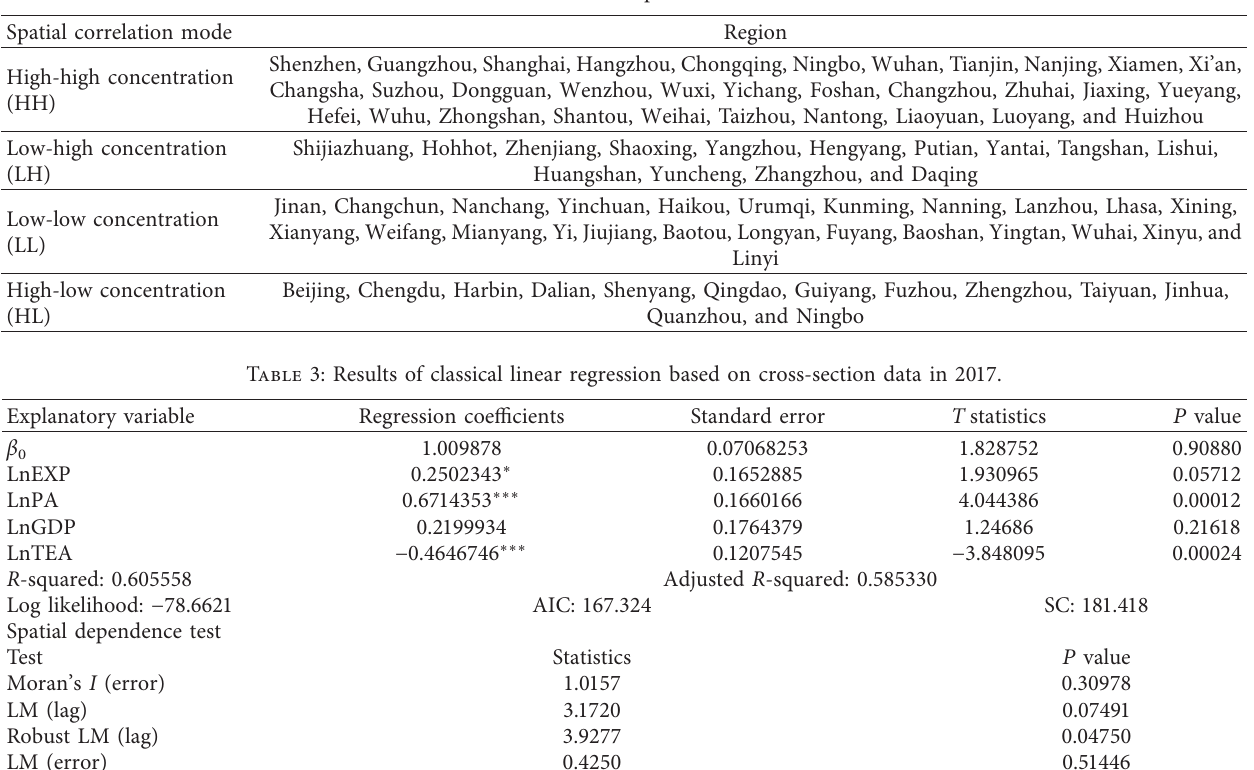
Figure 3: Moran scatter plot of the development level of smart cities of 83 cities. Table 2: Results of local spatial autocorrelation.